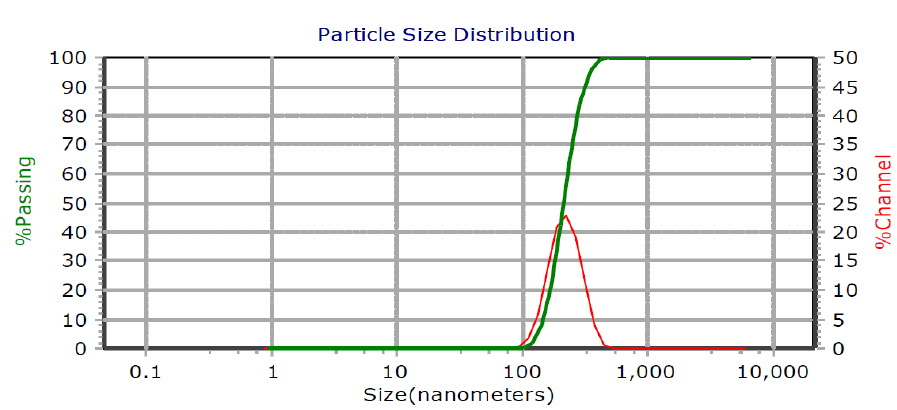
inhibition was larger at 150 µ L concentration as against 100 µ L concentration in all the